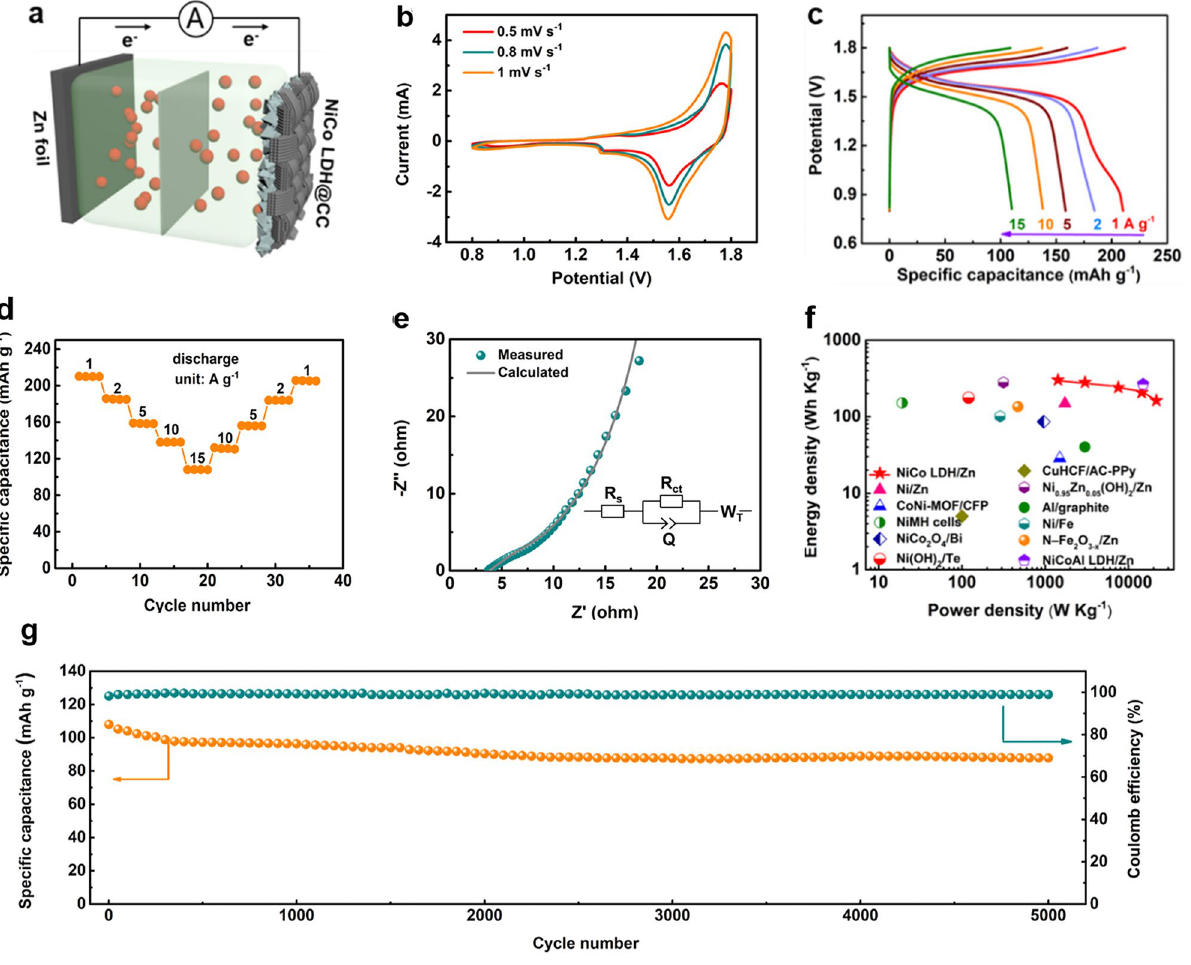
Fig. 5 a Structural illustration of NiCo-LDH@CC//Zn alkaline battery. The electrochemical performances of the aqueous Zn alkaline battery. b Cyclic voltammetry curves at different scan rates of 0.5, 0.8, and 1.0 mV s −1 , c GCD curves at different current densities of 1, 2, 5, 10, and 15 A g −1 , d corresponding rate capabilities, e Nyquist plots, f Ragone plots, g Long-term cycling